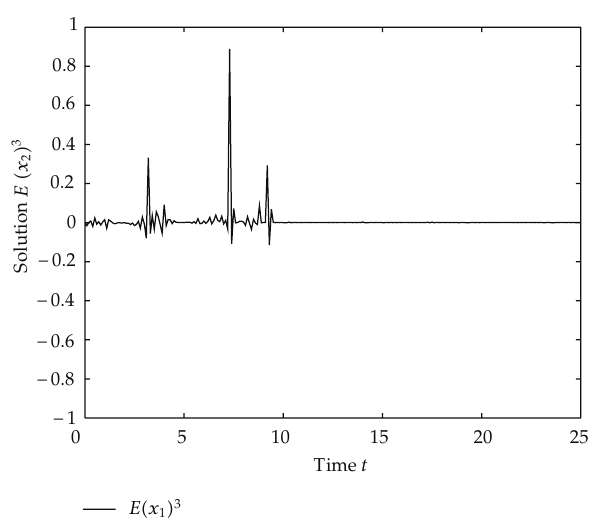
Figure 2: Numerical solution E (cid:6) x 3